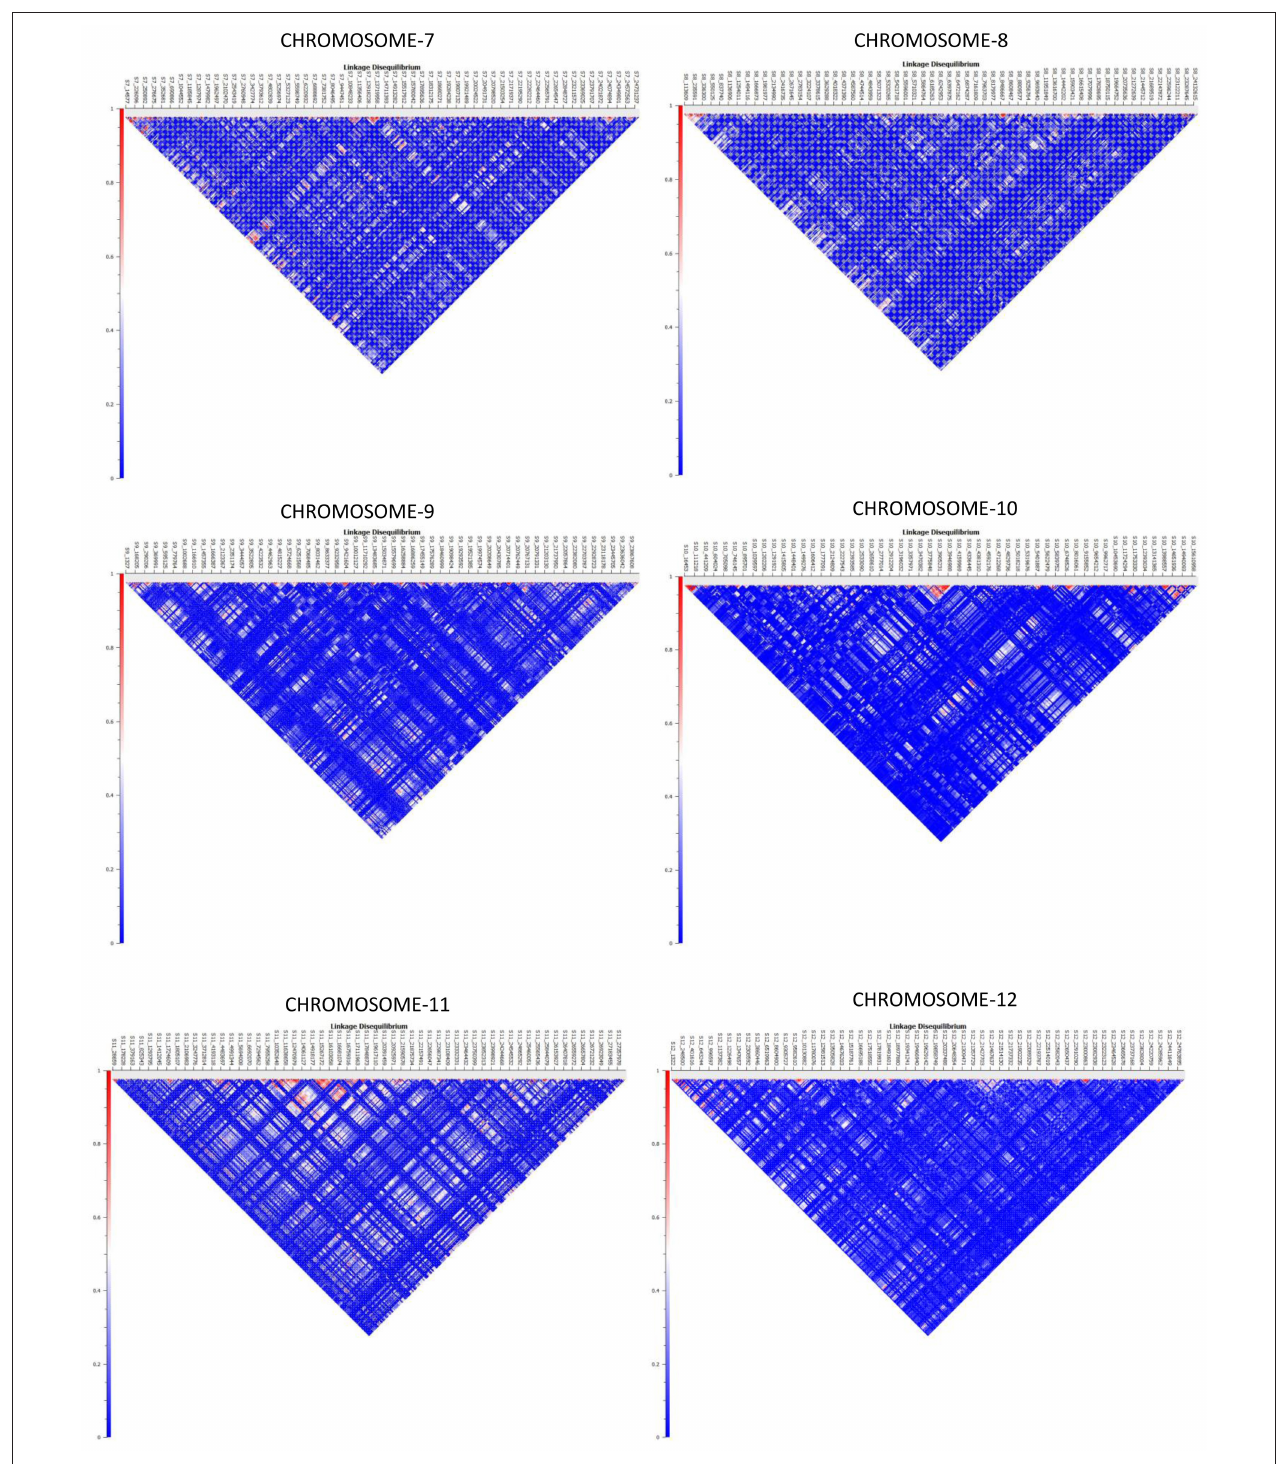
FIGURE 4 | Genome-wide distribution of LD ( r 2 ) across melon chromosomes 7–12. X-axis contains the SNP markers positioned on the physical map. Y-axis represents the intensity of LD as shown in the scale.